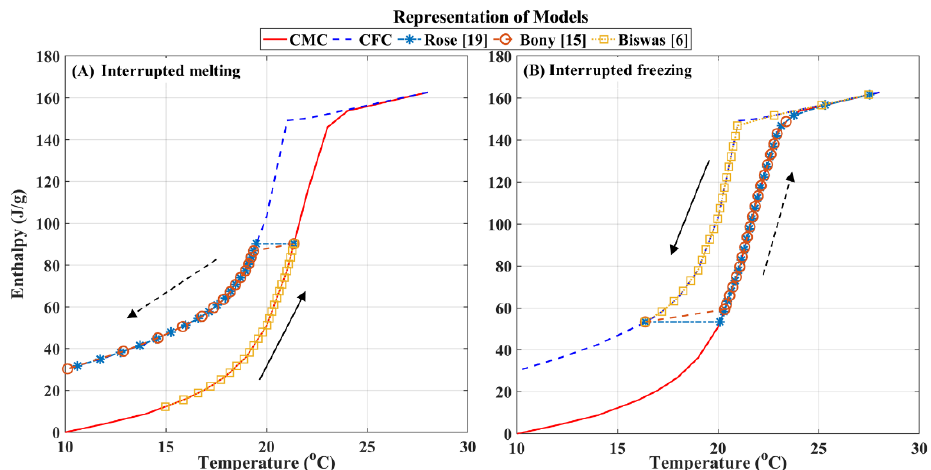
Figure 4. Graphical representation of the shift between the melting and freezing curves during interrupted phase change processes as assumed by different models. The solid black arrows indicate the direction of the initial melting/freezing process, and the dashed black arrows show the freezing/melting process following the interruption.